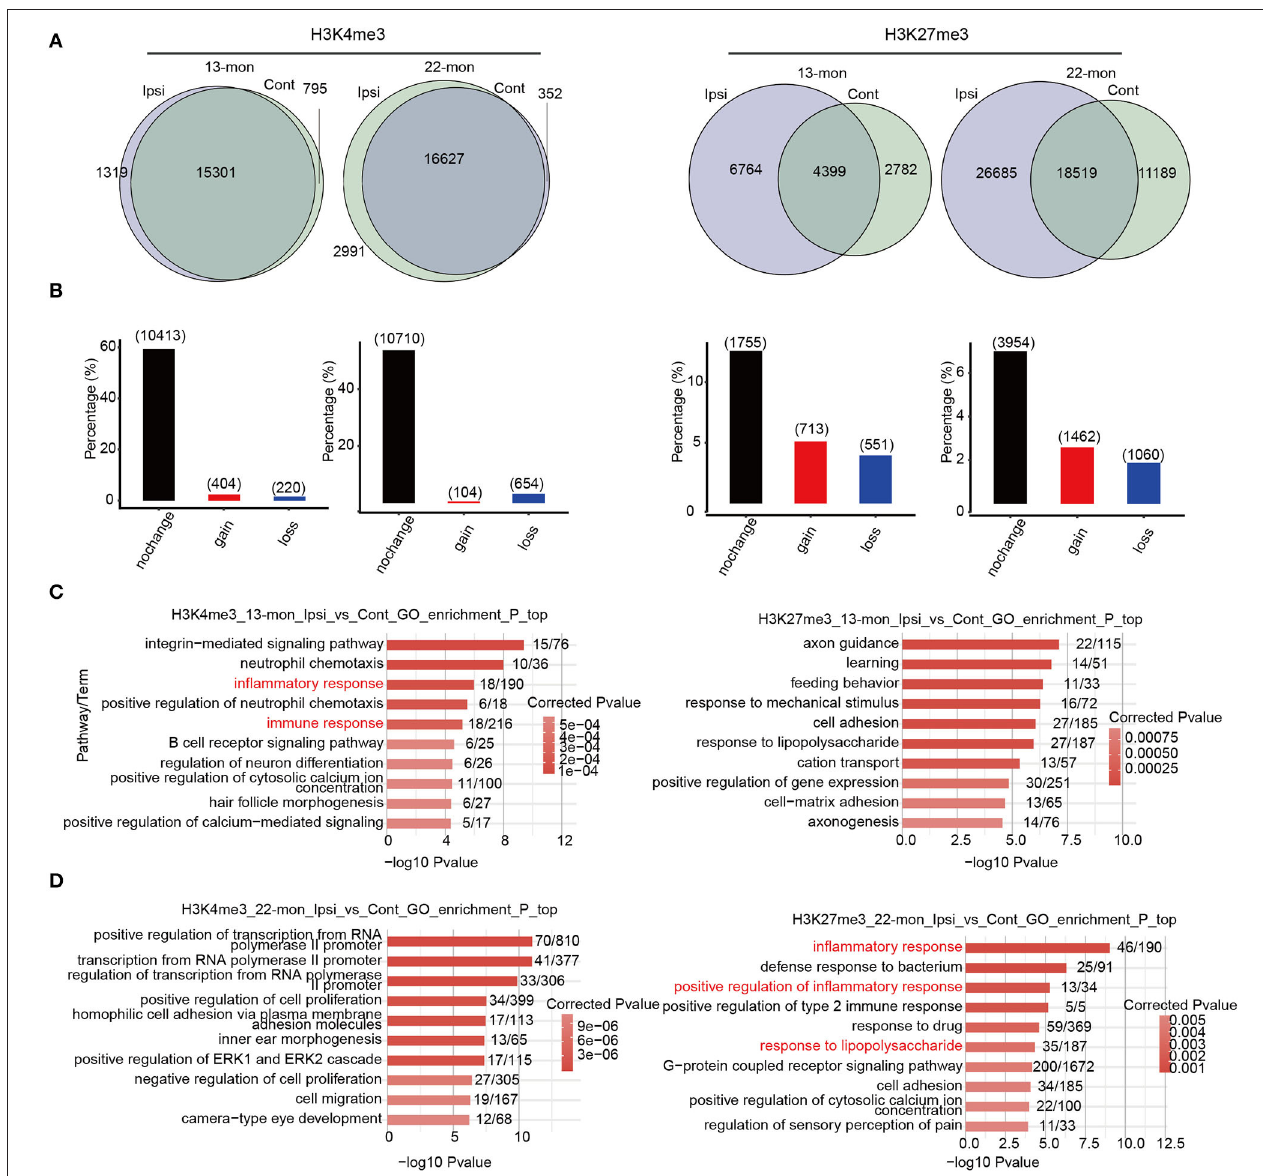
FIGURE 4 | The distribution change of histone marks between Ipsi and control reveals their relevance to immune response genes. (A) Venn diagram shows the number of overlapped and specific peak clusters and genes (in the parentheses) between Ipsi and control samples for H3K4me3 and H3K27me3 in 13-month-old (left) and 22-month-old rats (right). (B) Bar plot shows the number of overlapped and specific genes between Ipsi and control samples for H3K4me3 and H3K27me3 in 13-month-old (left) and 22-month-old rats (right). (C) Bar plot shows the top 10 enriched GO BP terms for pDMGs with H3K4me3 (left) and H3K27me3 (right) marks in 13-month-old ICH rats. (D) Bar plot shows the top 10 enriched GO BP terms for pDMGs with H3K4me3 (left) and H3K27me3 (right) marks in 22-month-old ICH